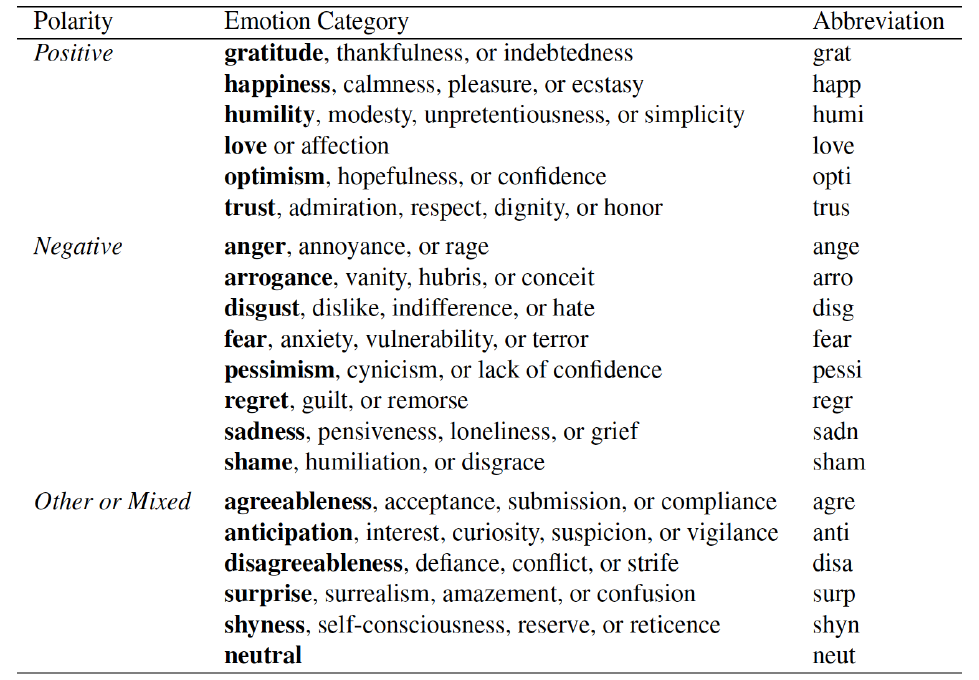
Figure 2. The list of emotions provided to annotators to label the title and art